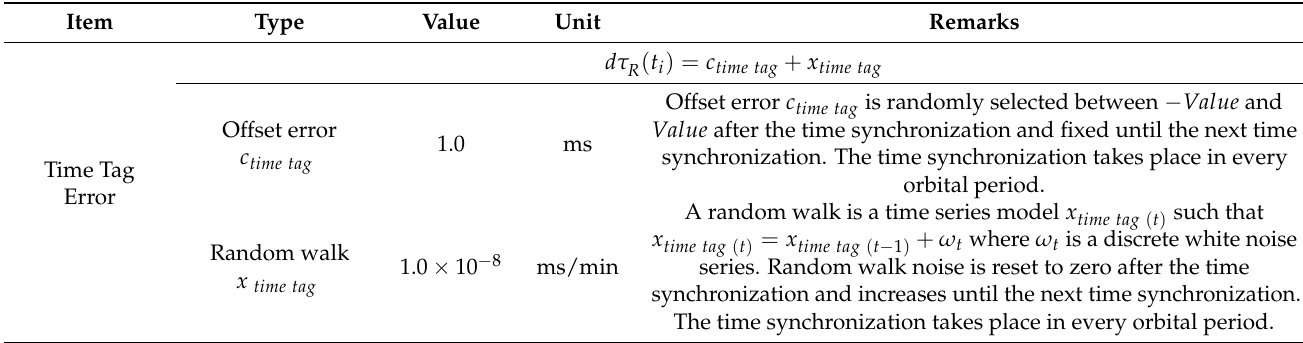
Table 7. Overview of the time tag error used in the simulation.